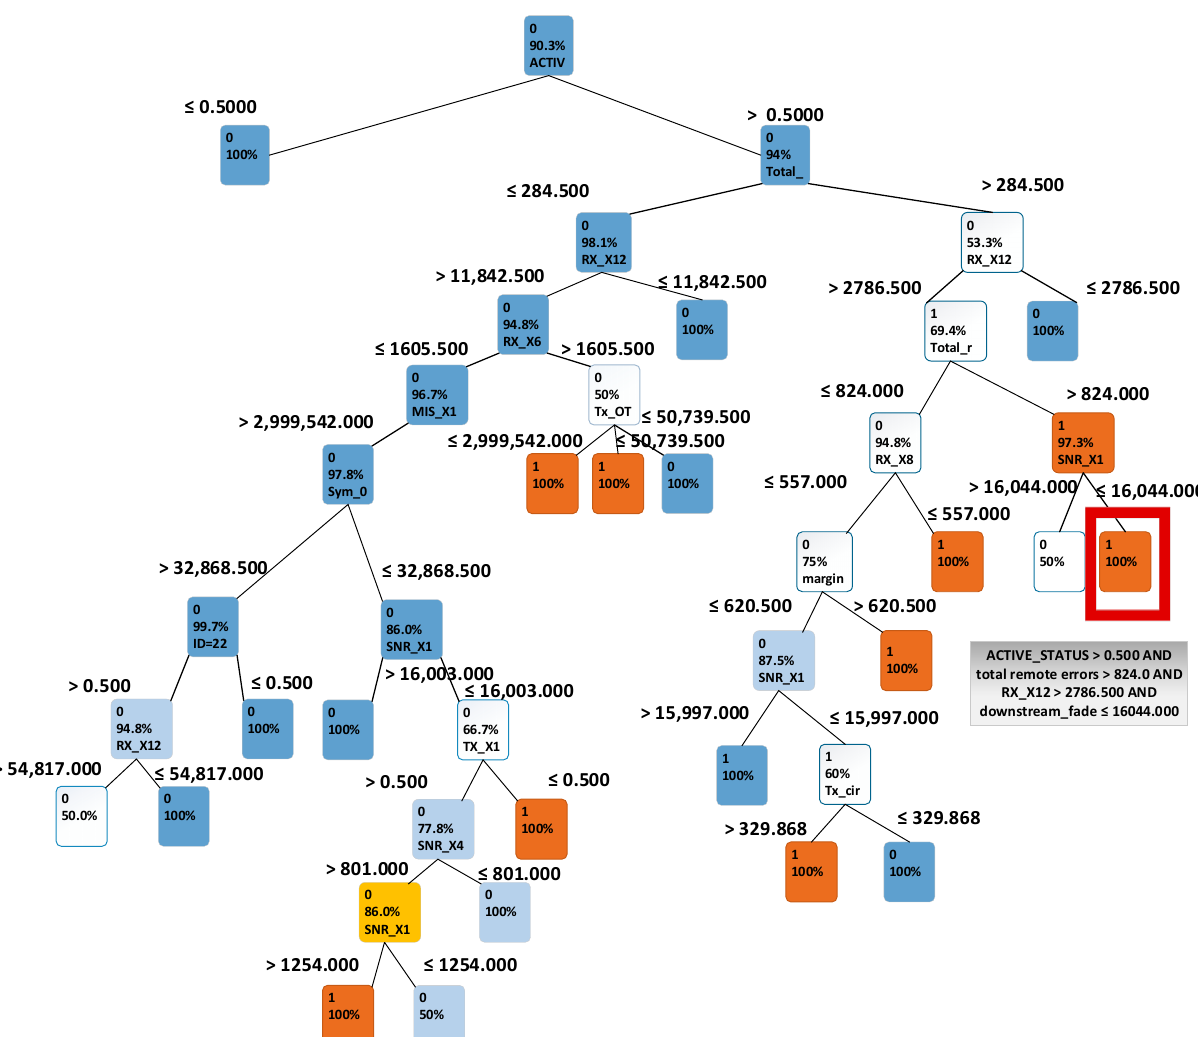
Figure 5. Classification decision tree for terminal data, with IS_DISRUPTED variable as a